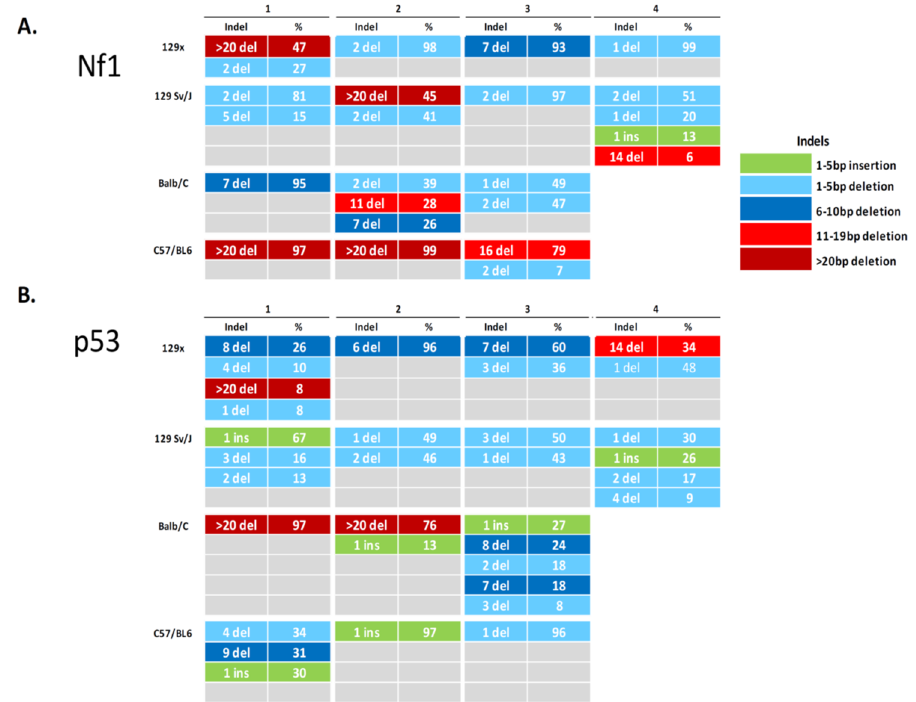
Figure 2. CRISPR/Cas9-induced insertions and deletions detected in Nf1 and p53 in MPNST-derived cell lines from different genetic backgrounds. Indel pattern analysis of the sgRNA-targeted regions of Nf1 ( A ) and p53 ( B ) demonstrates disruption of genomic targets in all tumors. The majority of indels detected in both Nf1 and p53 are frameshift mutations that result in inactivation of targeted proteins.